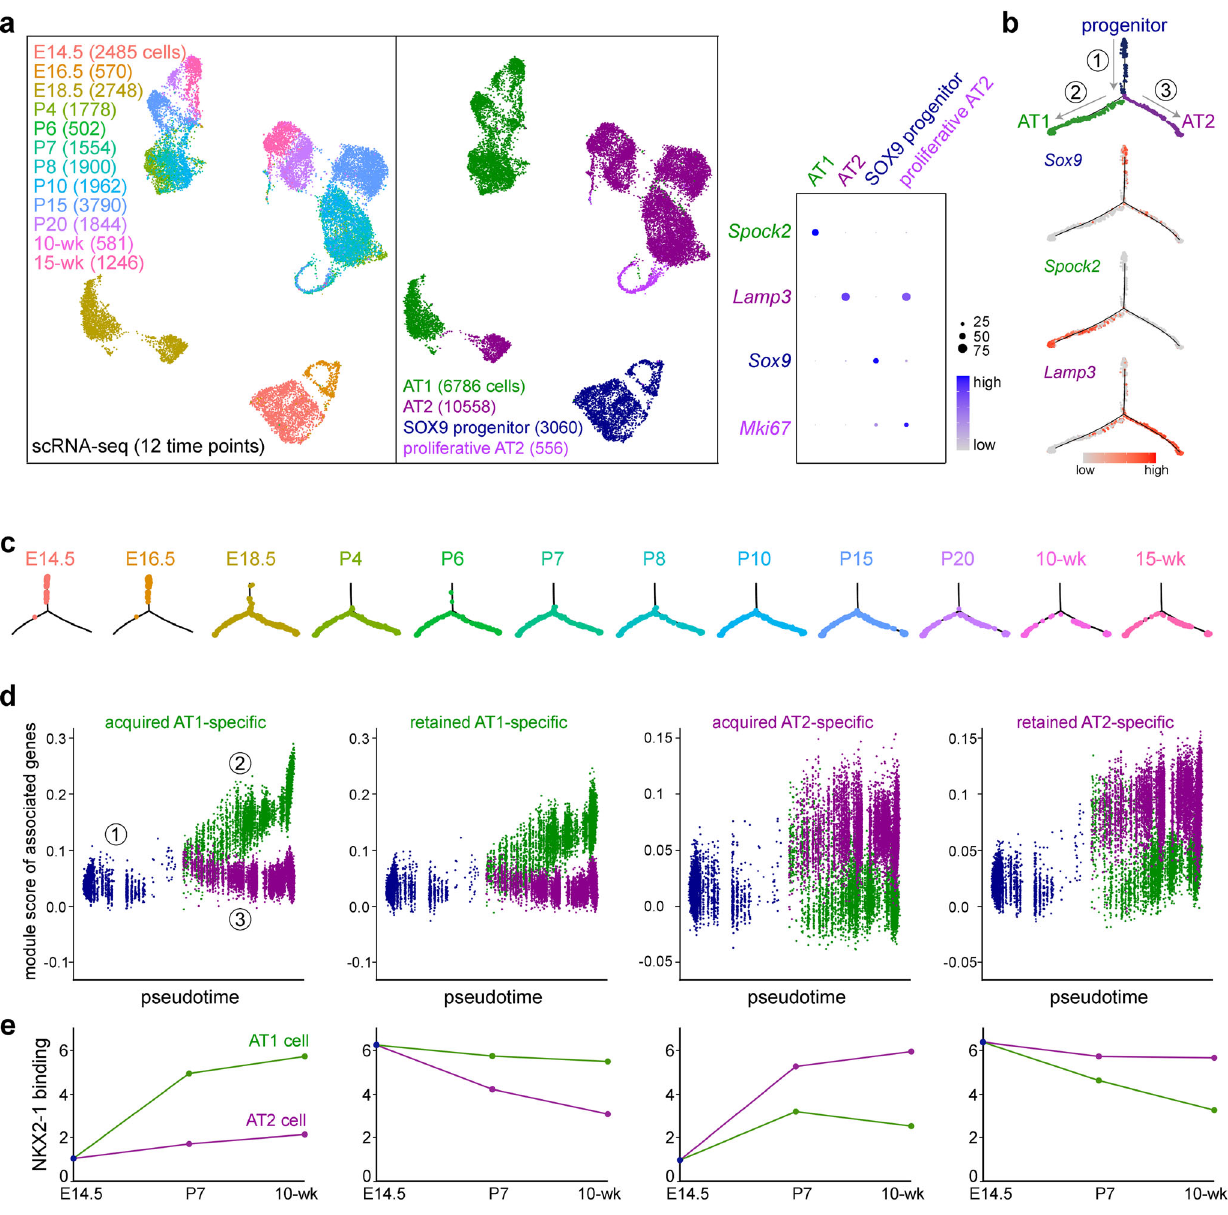
Fig. 4 Acquired and retained NKX2-1 sites have comparable kinetics in transcriptional divergence of progenitors toward opposing cell fates. a ScRNA- seq UMAPs (Uniform Manifold Approximation and Projection) of color-coded E14.5 to 15-week-old lungs identify the indicated cell types and numbers in the alveolar region and show the gradual transcriptomic shifts of AT1 and AT2 cells from SOX9 progenitors, as supported by the dot plot for AT1 ( Spock2 ), AT2 ( Lamp3 ), progenitor ( Sox9 ), and proliferative ( Mki67 ) cells. Cells from a similar developmental stage (P4, P6, P7, and P8) are clustered together, suggesting the differences among shifted clusters are largely biological. b Monocle trajectory analysis of cells in a excluding proliferative AT2 cells, showing three branches (circled number) consistent with SOX9 progenitors differentiating into AT1 or AT2 cells, as supported by expression of the respective markers Sox9 , Spock2 , and Lamp3 . The same Monocle trajectory in c split by sample time points and colored as in a . E14.5 and E16.5 cells are largely homogeneous and limited to branch 1 (progenitor branch). d Seurat module scores of gene sets associated with acquired or retained AT1 or AT2-speci fi c NKX2-1 sites as de fi ned in Fig. 3, plotted along the Monocle trajectories as numbered in c . e NKX2-1 binding signal of the four categories as in d in the AT1 or AT2 cell over time, using data from Fig. 3, showing that acquired and retained sites have distinct binding kinetics but comparable transcriptional allowing progenitors to progress toward AT1 cells. Formation of exaggerated AT2 cells in the Y/T Sox9 mutant suggested that resolving AT1 versus AT2 cell fate is a gradual process by mutant model, both AT1 and AT2 cells were targeted as descen- resisting differentiation toward the opposing cell fate so that, dants of SOX9 progenitors, and NKX2-1 ChIP-seq was performed without YAP/TAZ — the “ pro-AT1 ” factors, progenitors accelerate using whole lungs. To pinpoint the role of YAP/TAZ speci fi cally in toward the AT2 fate. Strikingly, although tamoxifen interfered AT1 cells and to test whether YAP/TAZ continued to function as with pregnancy and pups were born one day overdue, all Y/T Sox9 partner factors for NKX2-1 after cell fate speci fi cation, we gener- mutant pups were cyanotic and dead except for one that was ated Yap/Taz CKO/CKO ; Rosa Sun1GFP/ + ; Wnt3a Cre/ + mutants gasping — a sign of respiratory distress (Source Data). (abbreviated as Y/T Wnt3a ) and performed NKX2-1 ChIP-seq using